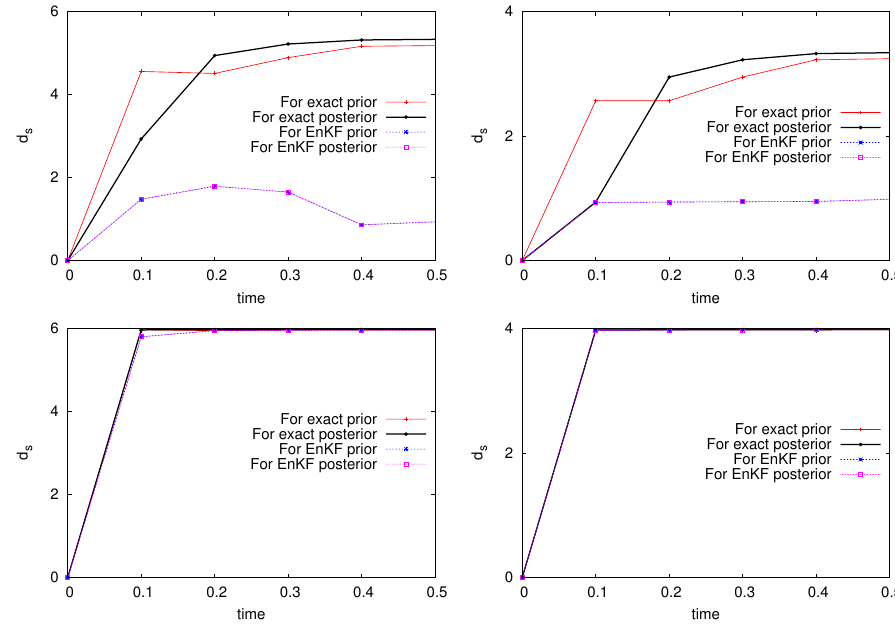
Fig. 7. The degree of freedom Eq. (8) for various distributions described in the text. Left column is for the full distributions on all the six variables of the model ( u 0 ,u 1 ,v 1 ,h 1 ,x,y ) while the right column is for the velocity variables ( u 0 ,u 1 ,v 1 ,h 1 ) . Top row is for the case of broad prior (see Fig. 4), bottom row for narrow prior (see Fig. 5).